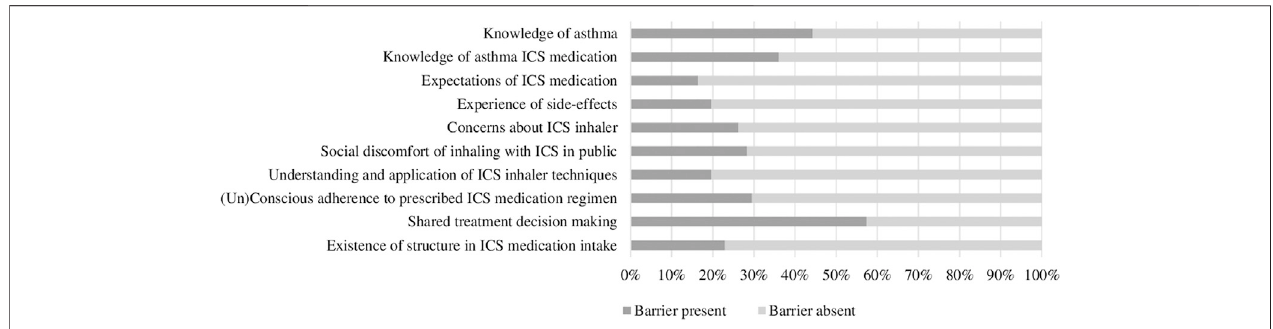
FIGURE 2 | Percentages of barriers present identi fi ed from the semi-structured interviews ( n (cid:1) 61). Abbreviations: ICS: Inhaled Corticosteroids.